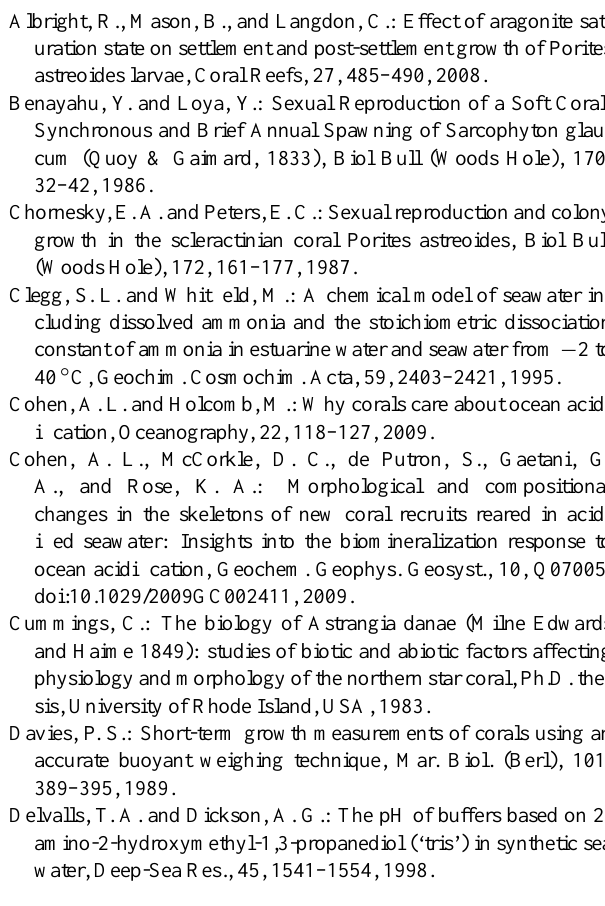
tivity of calcifying organisms to ocean acidification